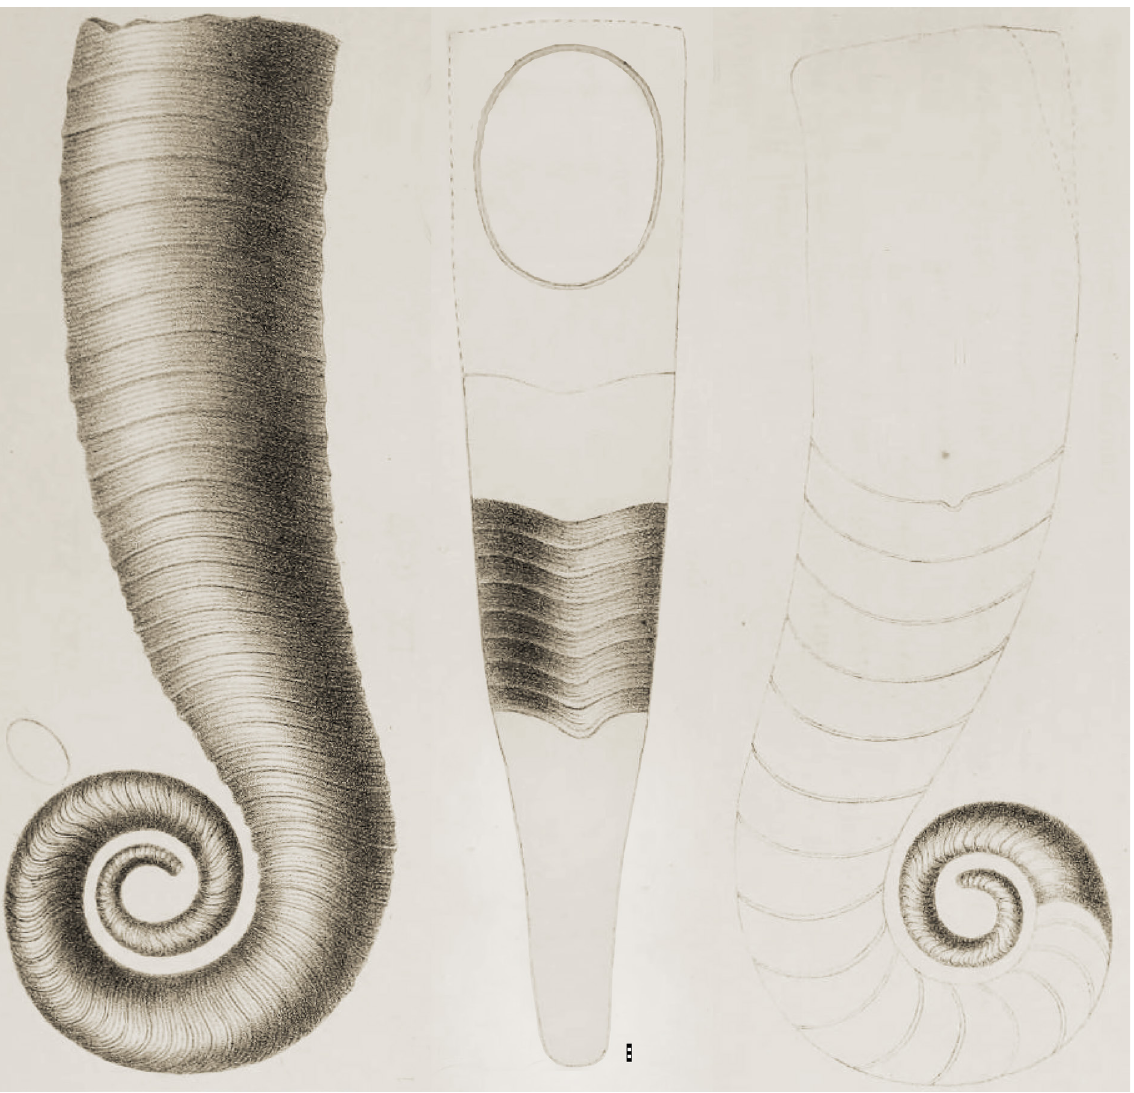
Fig. 26. Angelinoceras latum (Angelin, 1880); reproduction of illustrations by Angelin (1880: pl. 3 fig. 5). Scale bar units = 1